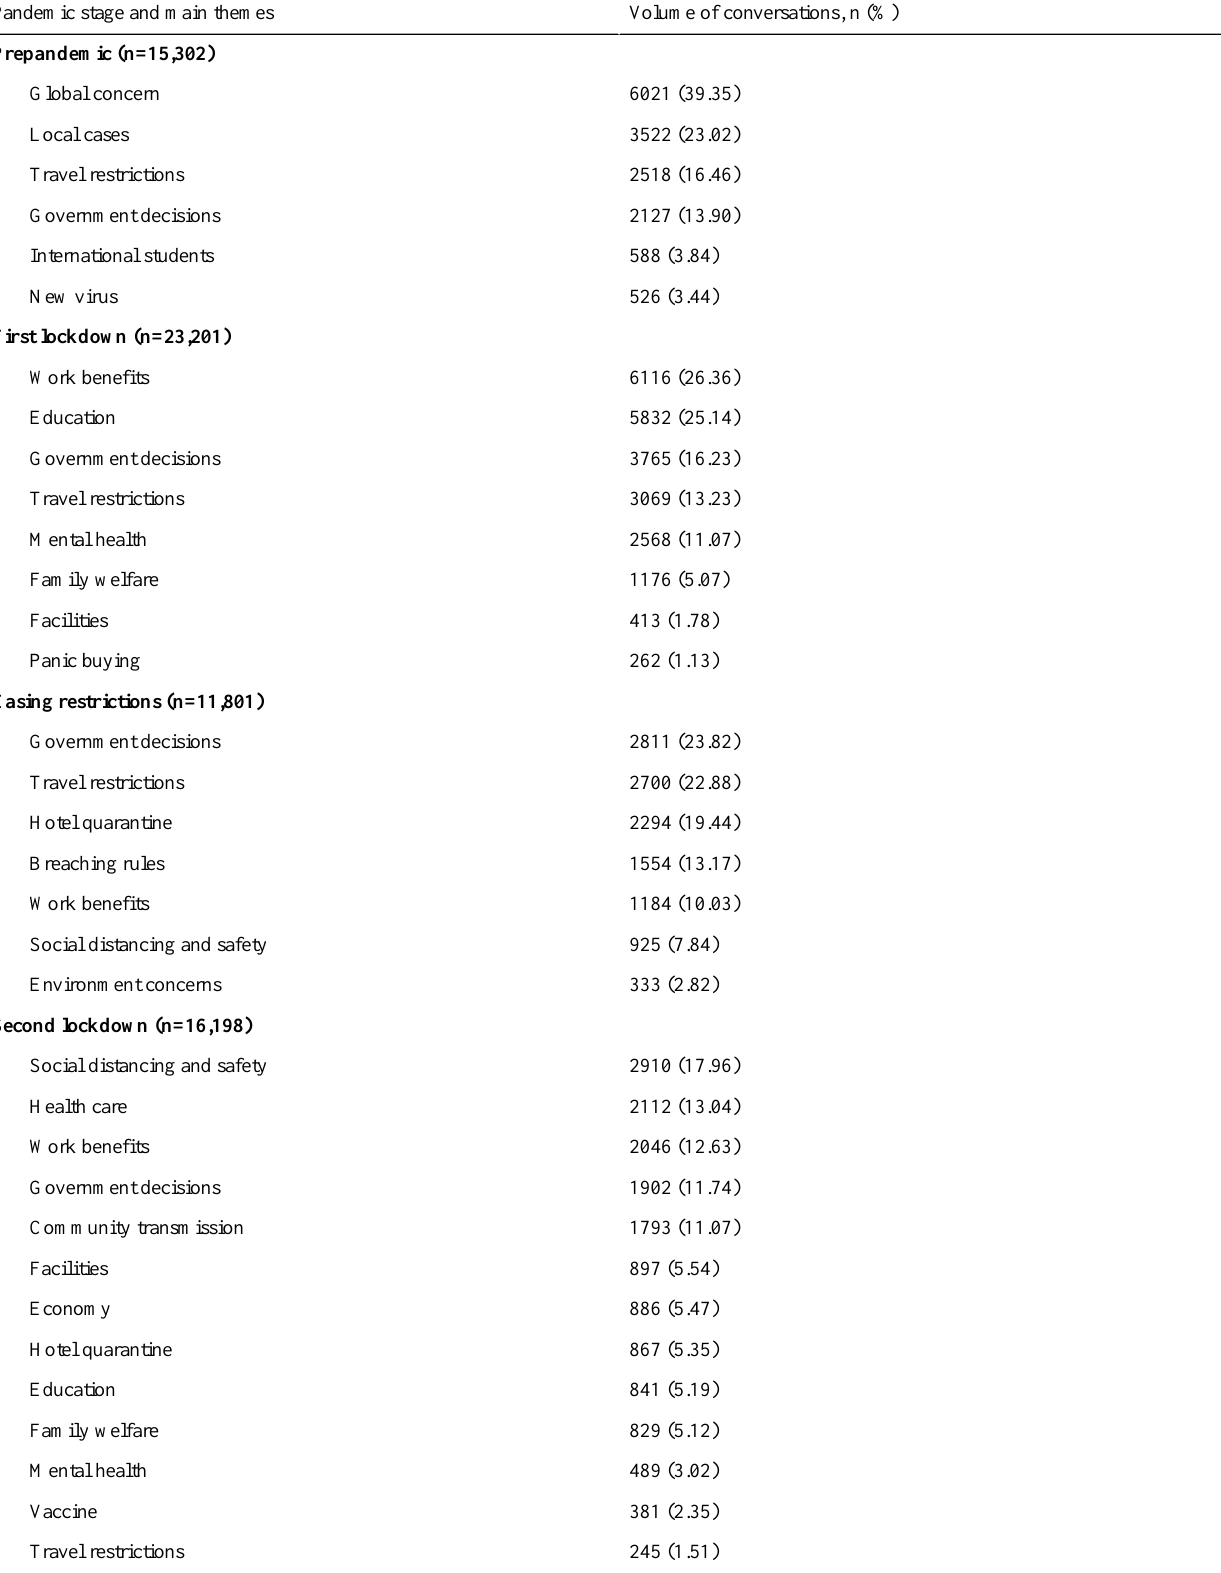
Table 2. Topics of discussion across the four stages of the